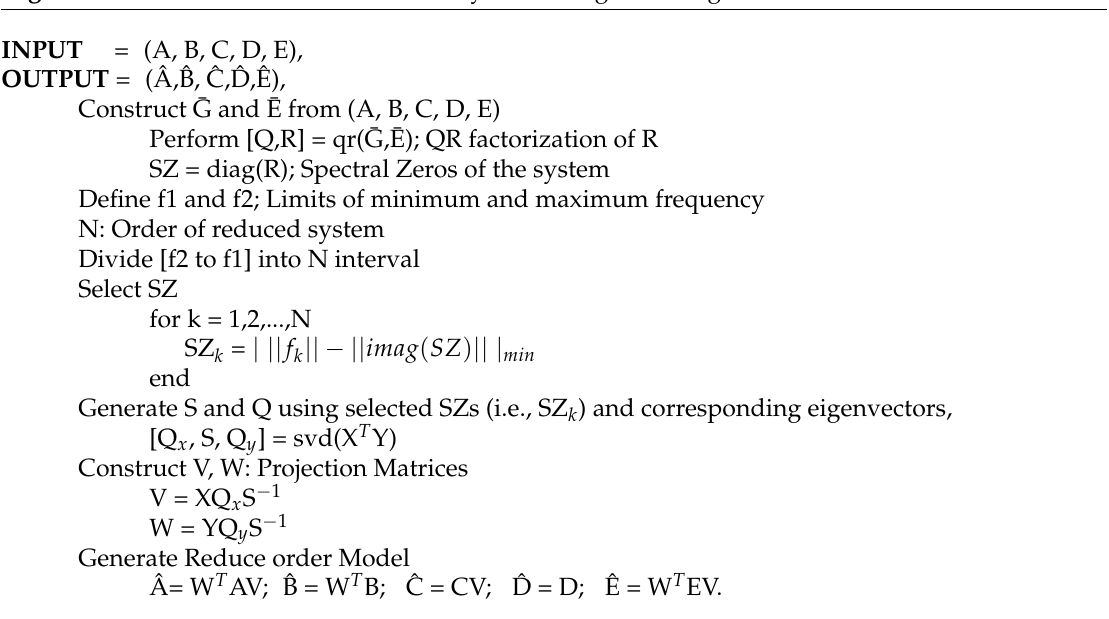
Algorithm 1 Pseudocode of RNSZ Passivity Preserving MOR